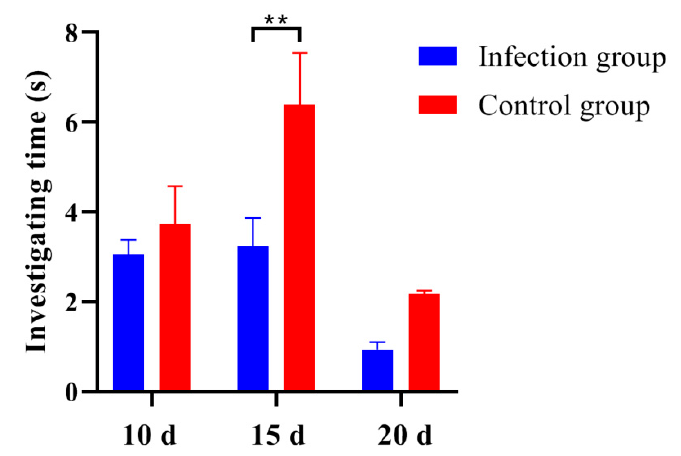
Figure 3. The parasitic infection decreased the attractiveness of ICR/CD-1 male mouse urine to females. Attractiveness was evaluated by recording the cumulative duration of female mice in sniffing and exploring the different urine samples within 3 min. All data are presented as means ± standard deviation. Two-way ANOVA was used for significance analysis, and all statistical analyses were performed with GraphPad Prism 8. ** p < 0.01.